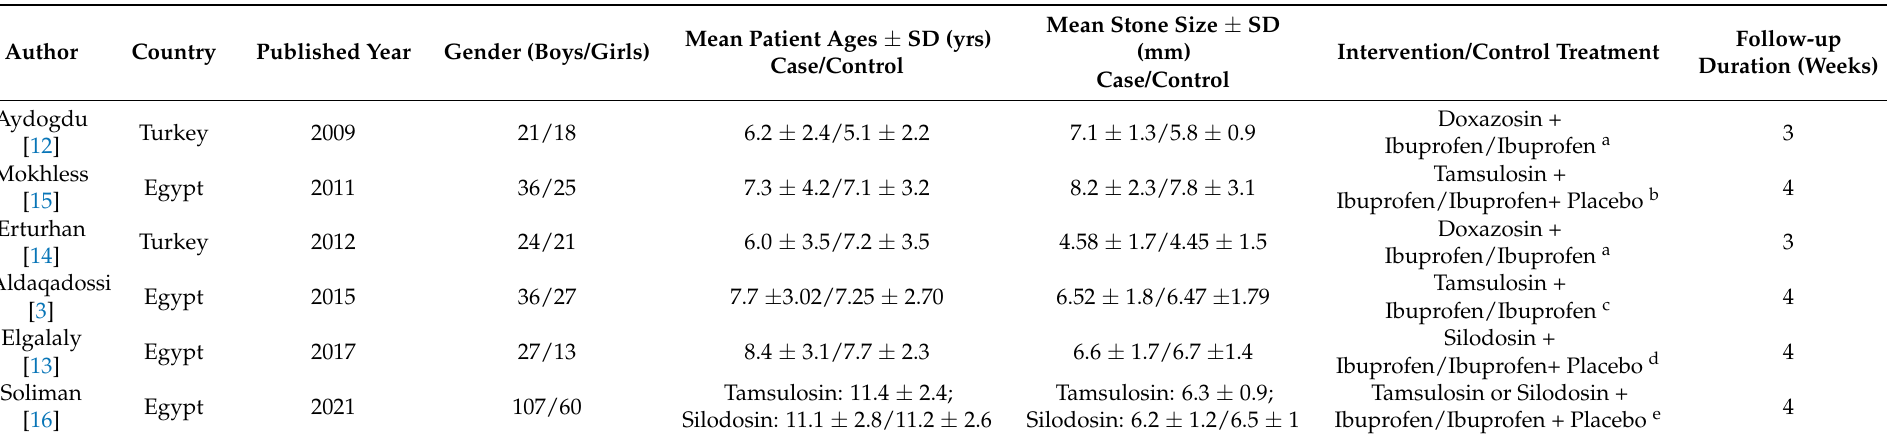
Table 1. Characteristics of the included